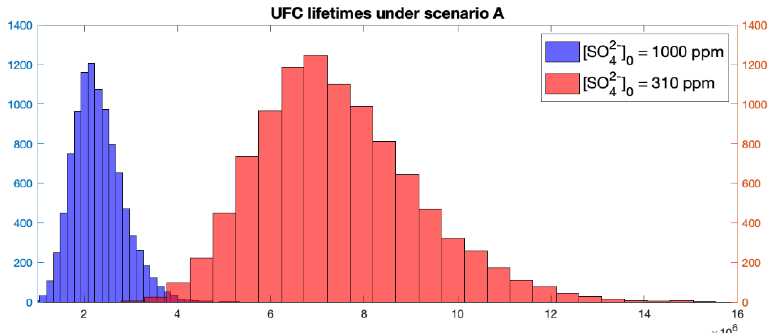
Figure 2. Sulphide concentration and flux to UFC for Scenario I.